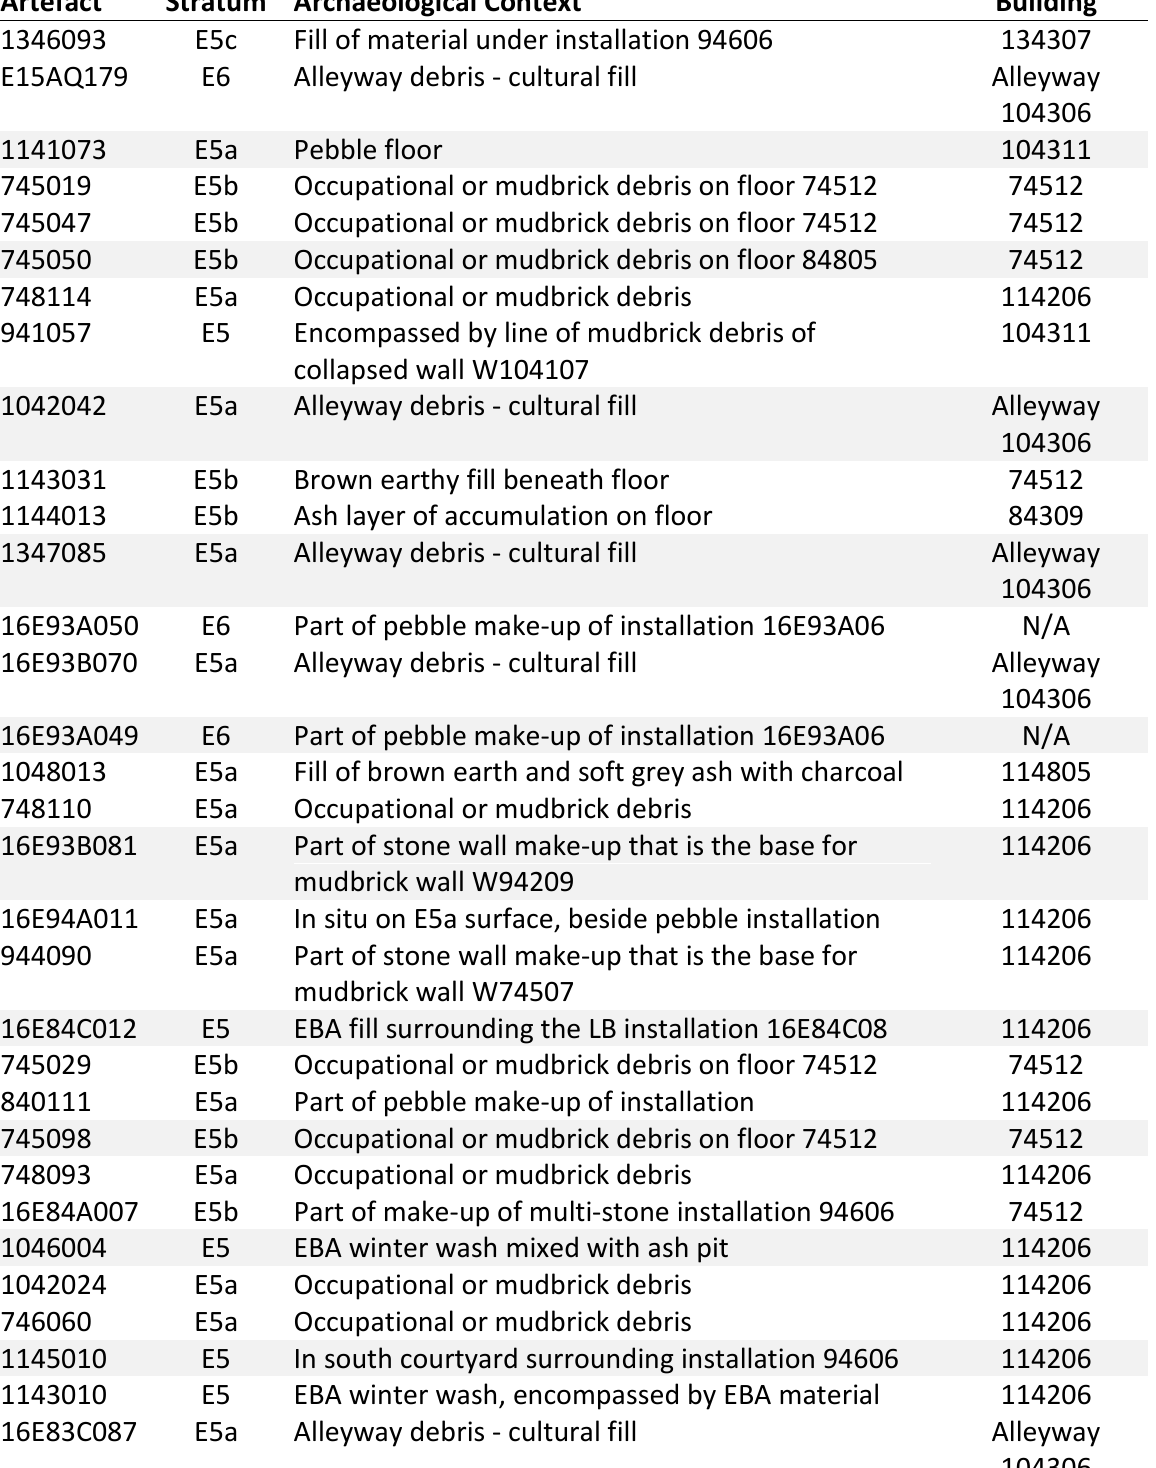
Table 1. Archaeological context of basalt artefacts. Abbreviations: N/A - not